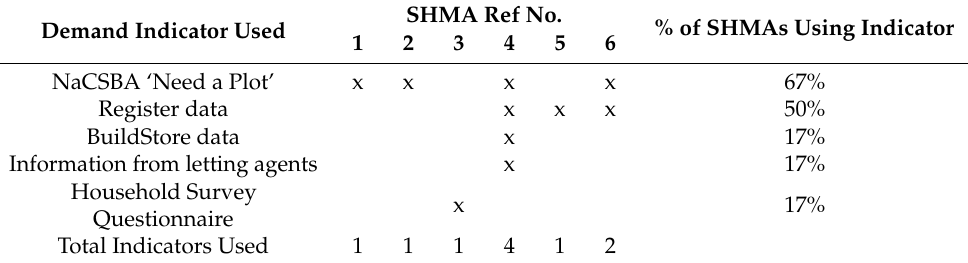
Table 7. Indicators of demand used in SHMAs.